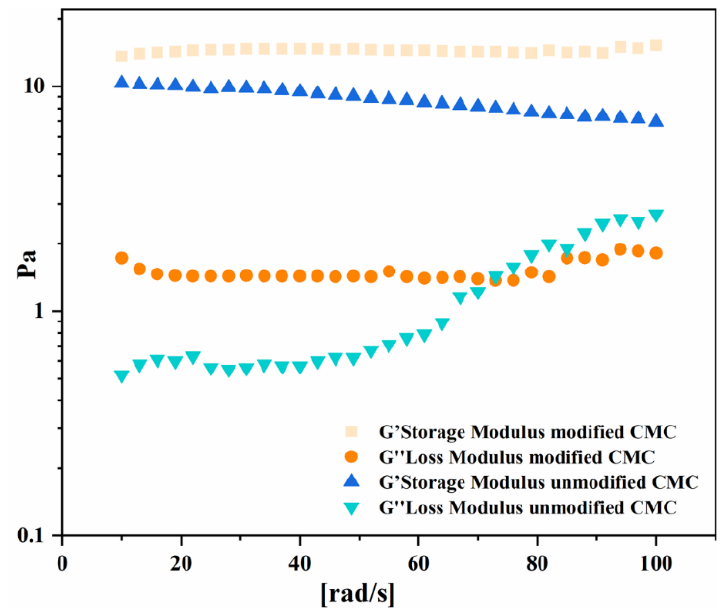
Figure 18. Storage and loss modulus of 0.5% modified and unmodified CMC crosslinked in water.